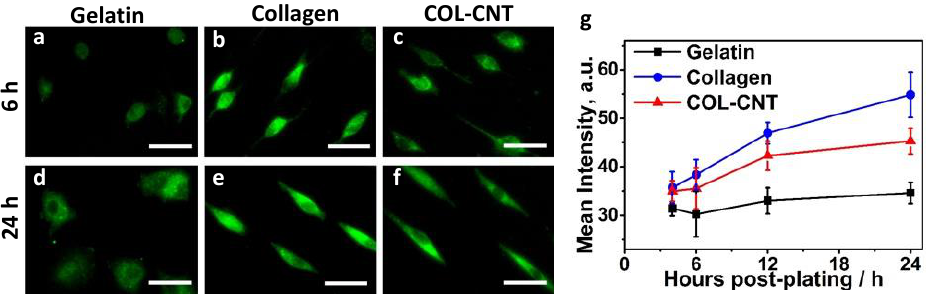
Figure 5. Time dependence of β-1 integrin expression in SKOV3 cells cultured on various matrices. ( a – f ) Immunofluorescent images of cells cultured on various matrices for 6 ( a – c ) and 24 h ( d – f ), respectively. Bar size: 115 μm. ( g ) ImageJ quantification of the change in β-1 integrin expression with time on the matrices.